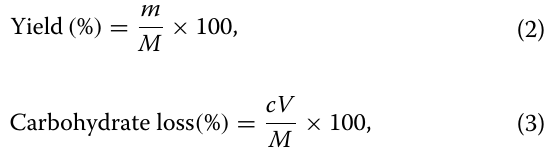
Table 1 Chemical composition of pinewood and bleached pulp